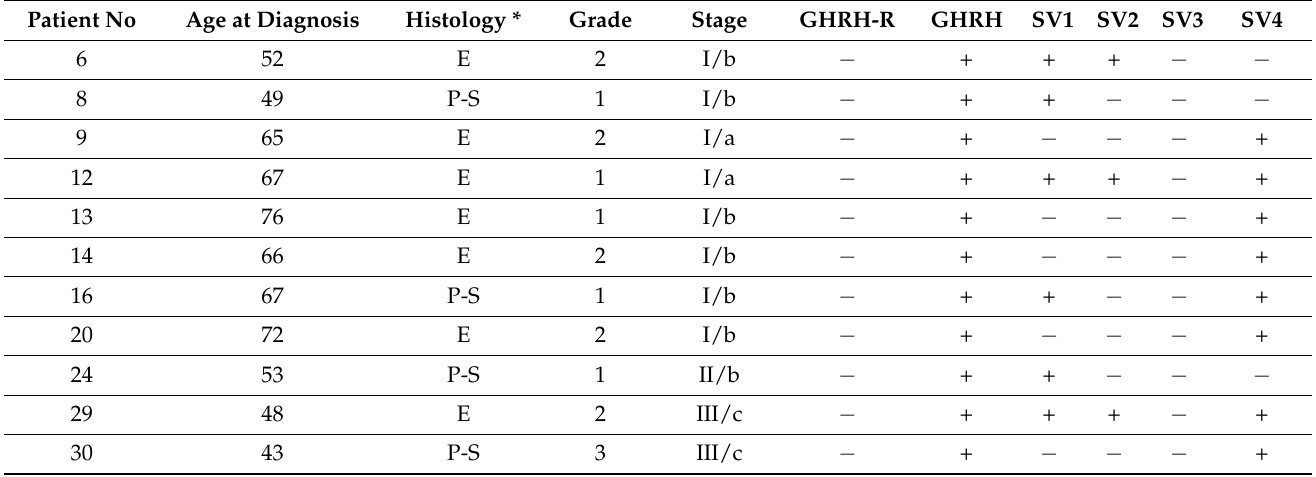
Table 2. Clinicopathological features and mRNA expression pattern of receptors for GHRH, and GHRH ligand in endometrial cancer specimens positive for any of the GHRH receptor splice vari- ants.